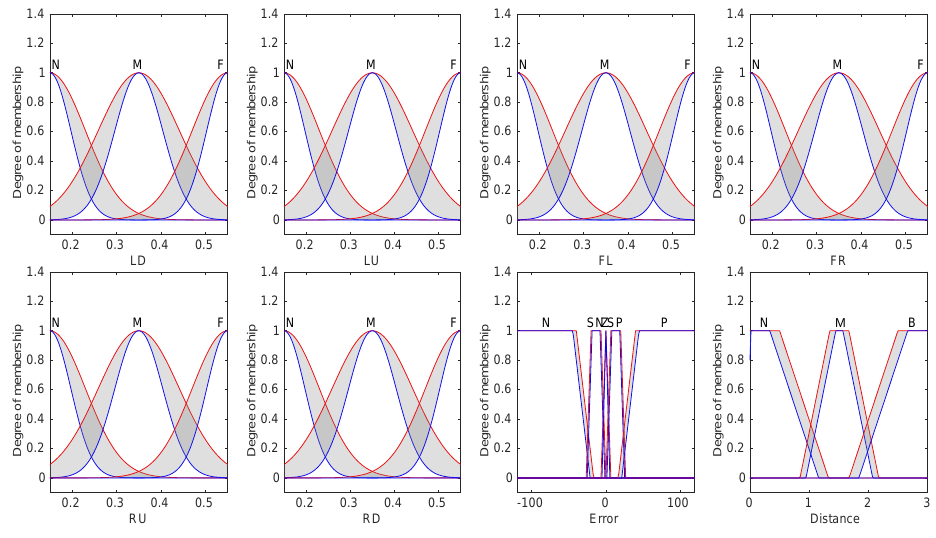
Figure 5. Type-2 fuzzy sets in the inputs.